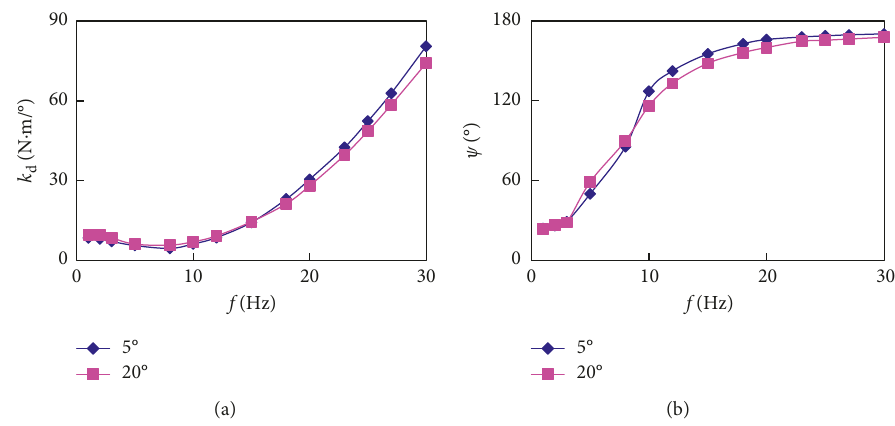
Figure 22: Different pretwisted angles at θ